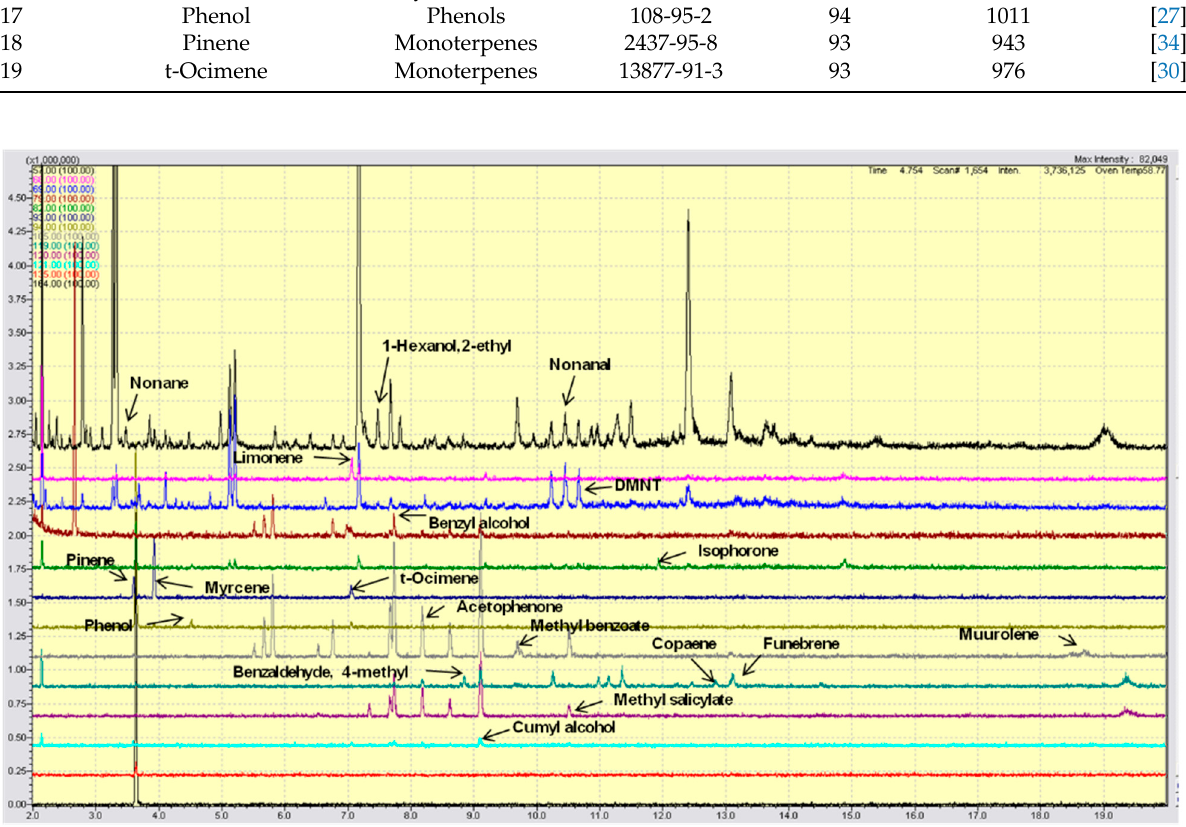
Figure 1. Gas chromatograms of specific olive tree VOCs evaluated using single ion monitoring (SIM) analysis. Different colors are used to better visualize the SIM signals of the VOC compounds (see Table 2), whose peaks are indicated by arrows.